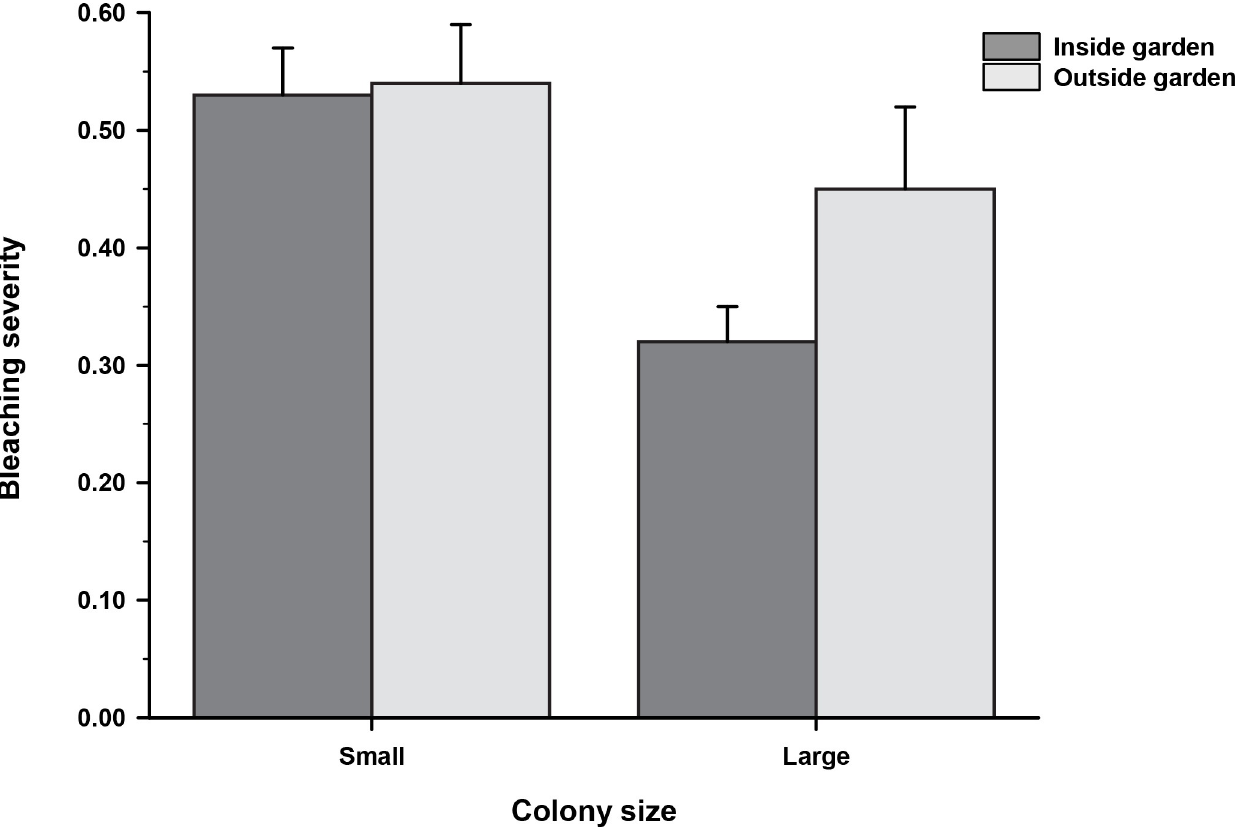
Fig 3. Bleaching severity as a function of farmerfish garden status. For colonies with � 5% bleached tissue, the mean ( ± SE) bleaching severity (proportion of a colony’s tissue that bleached) by colony size class as a function of farmerfish garden status. Small colonies were more severely bleached ( p < 0.005). See Fig 2 for the numbers of bleached colonies by size and garden status.